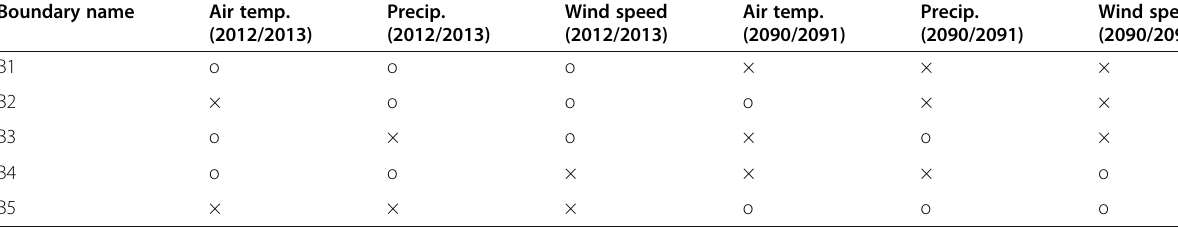
Table 3 Study cases under various weather conditions for parametric studies Boundary name